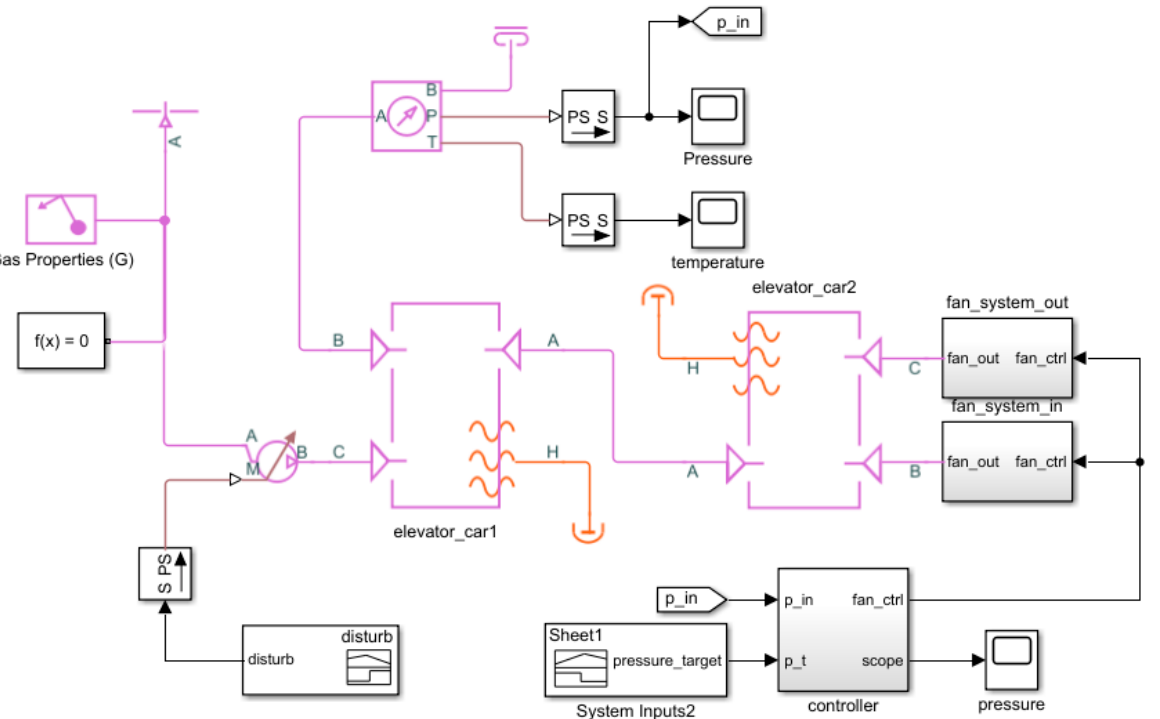
Figure 17. Simulation model of the high-speed elevator car air pressure compensation system.